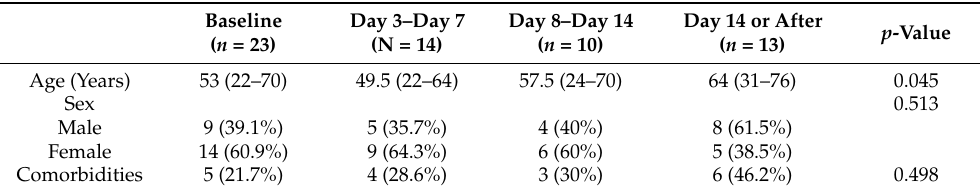
Table A1. Baseline Characteristics of Subjects by time point